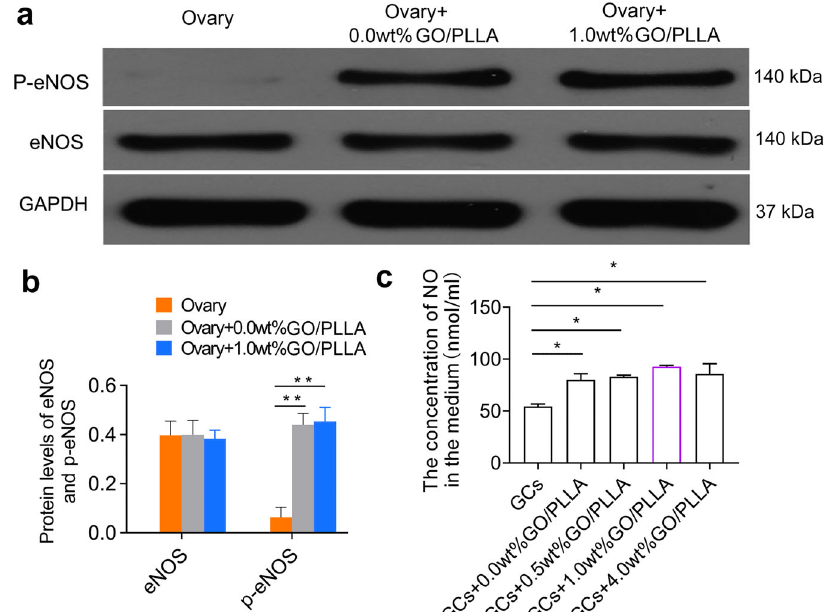
Fig. 7 eNOS and p-eNOS expression levels in transplanted ovarian tissue in the three groups and NO production in the supernatant of granulosa cells co-cultured with different concentrations of GO/PLLA nano fi ber scaffolds. a Representative image of western blot. b Protein levels of eNOS and p-eNOS based on the relative gray value of the western blot. c The concentration of NO in the supernatant of GCs co- cultured with different concentrations of GO/PLLA nano fi ber scaffolds. All the western blots were con fi rmed to be derived from the same experiment and processed in parallel. Statistical signi fi cance levels are set at *P < 0.05, **P < 0.01 by one-way ANOVA (Multiple comparisons). Data are presented as mean ±